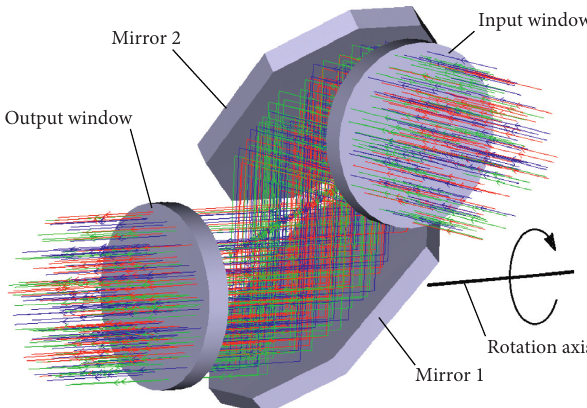
Figure 1: Optical layout of polarization compensated TSM.